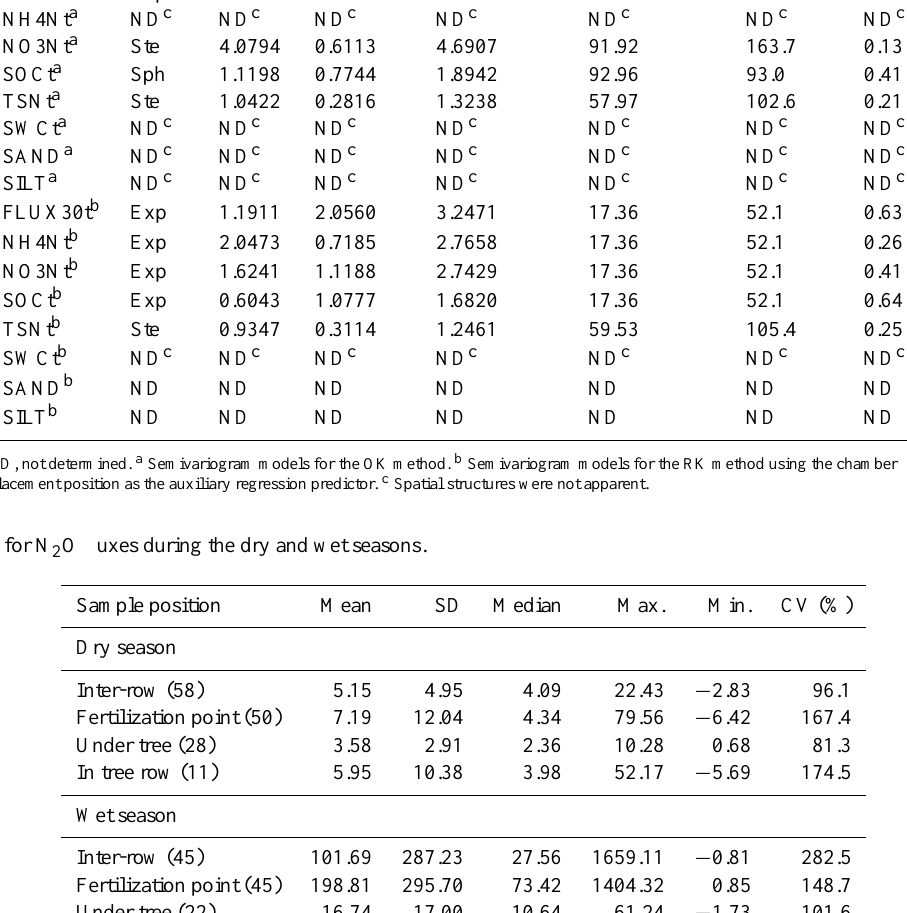
Table 2. Semivariogram models for N 2 O fluxes and the environmental factors. Variable Model Nugget Partial sill Sill (nugget + Distance Effective partial sill)